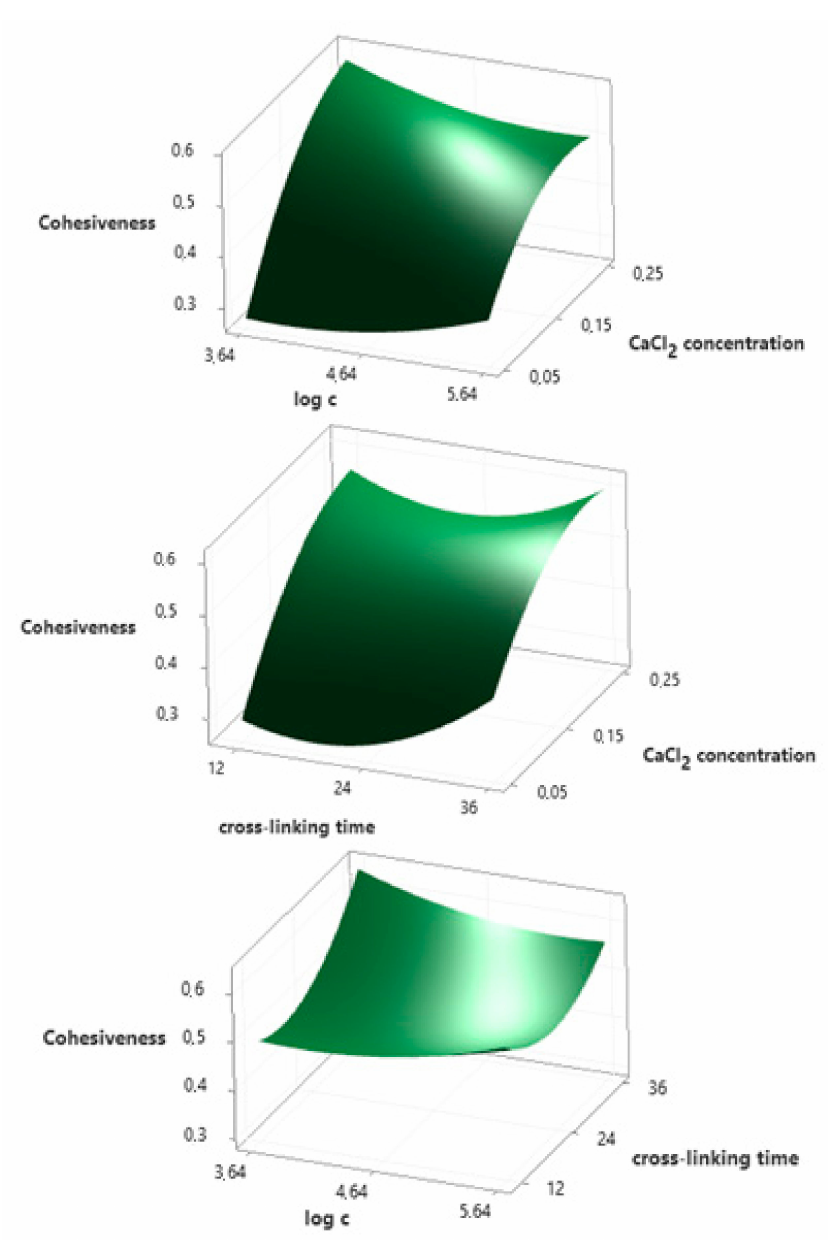
Figure 4. Surface plots presenting the effect of selected independent variables on the cohesiveness of